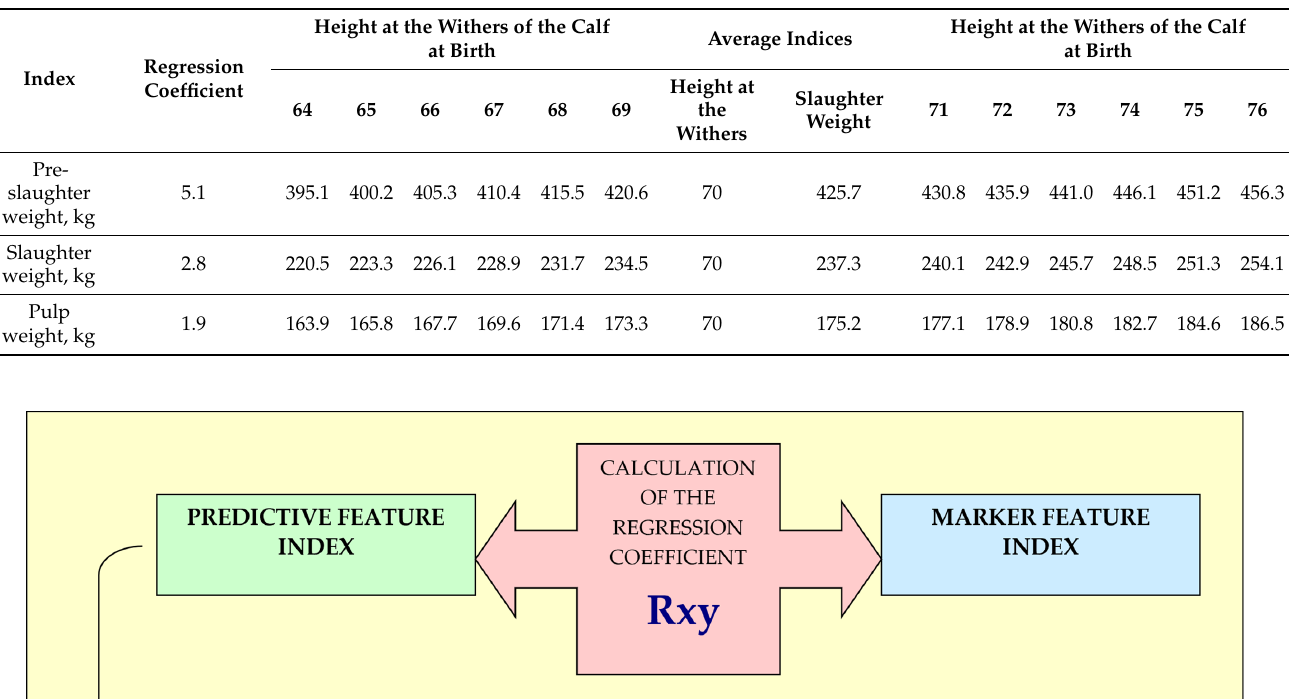
Table 5. Table for predicting the meat productivity of animals by their height at the withers at birth.